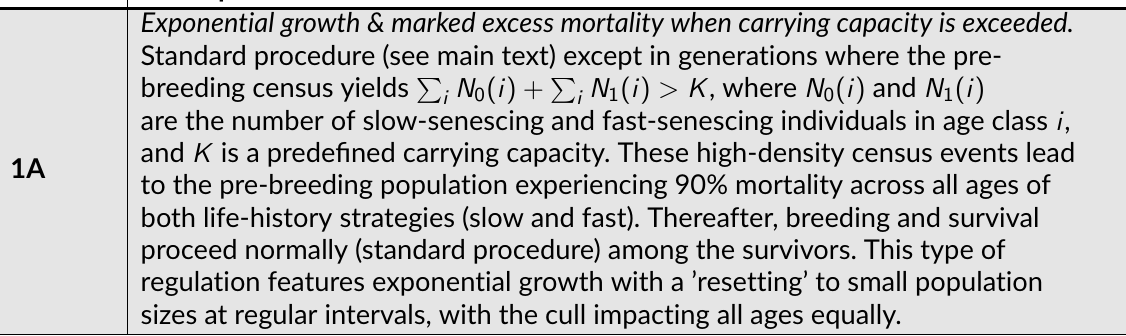
Table 2 – Description of each of the ten scenarios used to create Figure